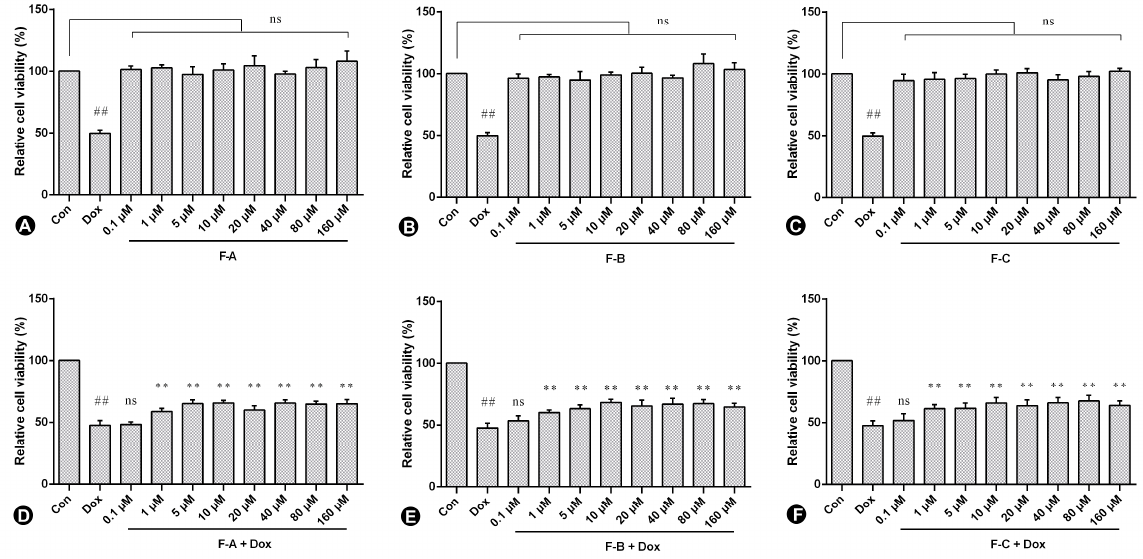
Figure 2. The effect of three flavonoids on Dox-induced cytotoxicity in H9c2 cells. Cell viability of H9c2 cells after exposure to different concentrations of F-A ( A ), F-B ( B ), and F-C ( C ) without Dox and the protective effect of F-A ( D ), F-B ( E ), and F-C ( F ) on Dox-induced cytotoxicity in H9c2 cells. Results are mean ± SEM from three independent experiments. ## p < 0.01 vs. control, ** p < 0.01 vs. Dox treated group. ns, not significant.